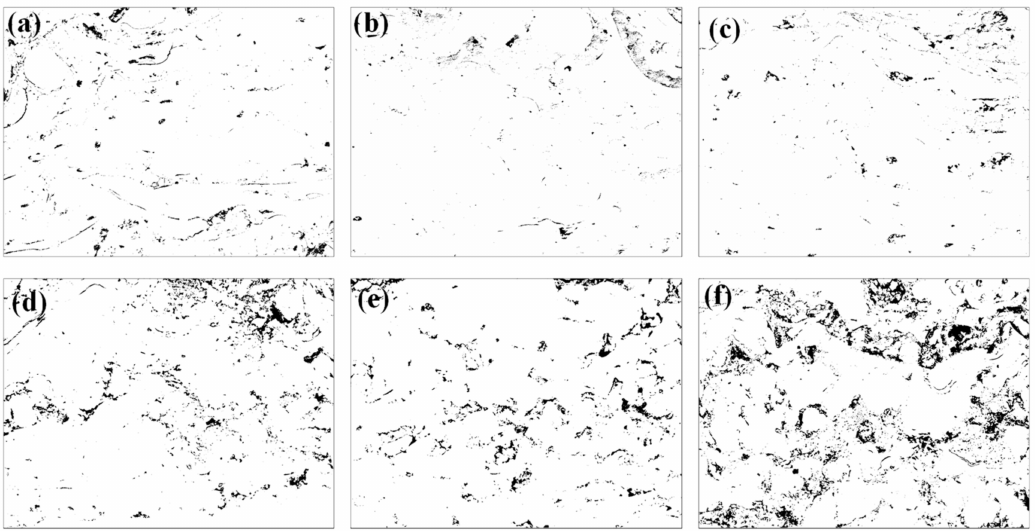
Figure 2. Corresponding grayscale images for porosity of ( a ) as-sprayed and annealed coatings at ( b ) 300 ◦ C ( c ) 400 ◦ C ( d ) 500 ◦ C ( e ) 600 ◦ C ( f ) 700 ◦